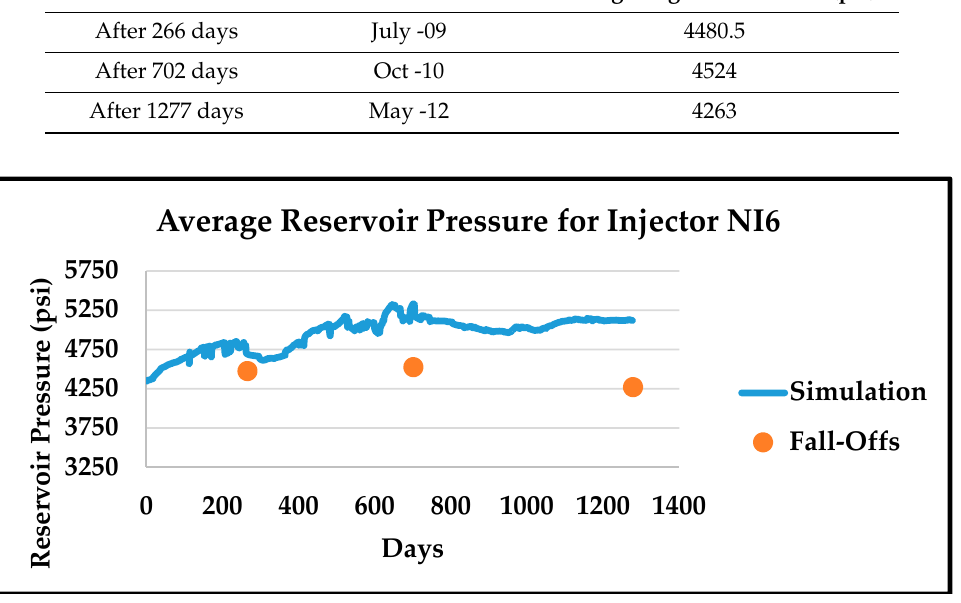
Figure 29. Calculated vs. fall-off reservoir pressures around Well NI6.